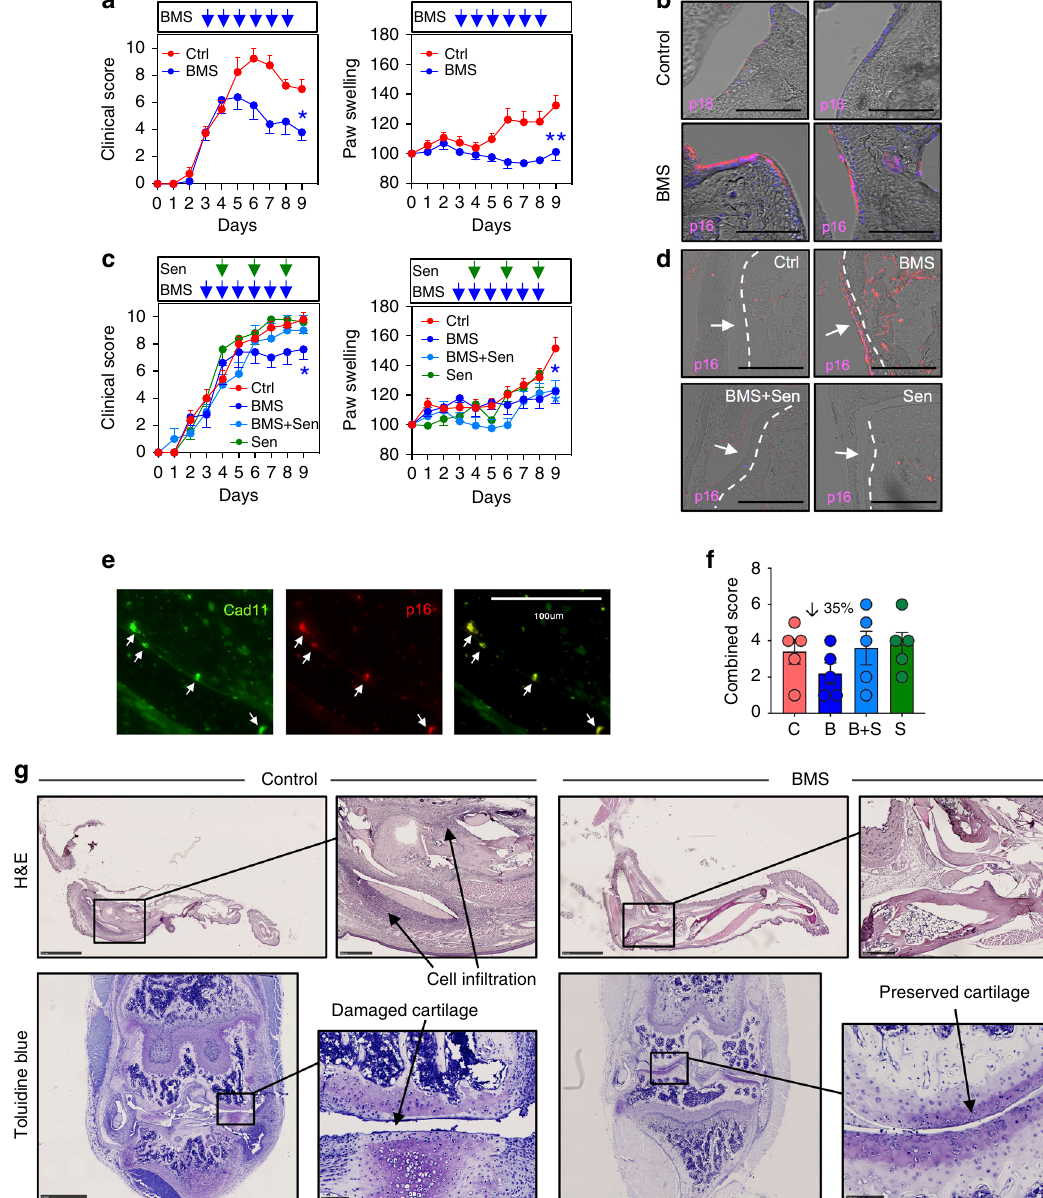
Fig. 6 Anti-arthritic actions of BMS are associated with SF senescence. a Arthritis was induced in C57BL/6NCrl mice with two injections of 100 μ l KBN serum on day 0 and day 2. BMS was administered intraperitoneally daily at the dose of 18 mg/kg from day 3. Clinical score and paw swelling were recorded daily. Data are mean ± SE ( n = 5, Student ’ s t -test vs. control day 9, Ctrl; * p < 0.05, ** p < 0.01). b p16 INK4 expression was assessed by immuno fl uorescence on EDTA-decalci fi ed and paraf fi n-embedded knee joint sections. p16 INK4 immunostaining is shown in pink while nuclear staining with DAPI is in blue. Scale bars indicate 100 μ m. c Arthritis was induced with two injections of 150 μ l KBN serum on days 0 and 2. BMS was administered intraperitoneally at a daily dose of 18 mg/kg from day 3. From day 4, senolytics (Sen, dasatinib + quercetin at doses of 2.5 and 10 mg/kg, respectively) were administered intraperitoneally on alternate days. Data are mean ± SE ( n = 5, Student ’ s t -test vs. control at day 9, Ctrl; * p < 0.05). d p16 INK4 expression was assessed by immuno fl uorescence on EDTA-decalci fi ed and paraf fi n-embedded knee joints sections. p16 INK4 is shown in pink. Arrows and dotted lines indicate synovial lining. e Co-localization by immuno fl uorescence of senescence marker p16 INK4 and the SF marker cadherin-11, Cad11, in knee joins of arthritic mice treated with BMS. Scale bars indicate 100 μ m. f Representative images of H&E (ankle joints) and Toluidine blue (knee joints) staining, indicating the degree of cell in fi ltration (H&E) and cartilage integrity (Toluidine blue) in control and BMS-treated mice. Data are mean ± SE ( n = 5). g The extent of cell in fi ltration and cartilage damage were combined in a cumulative damage score (max = 6). Data values are mean ± SE ( n = 5). Scale bars indicate 2.5 mm and 500 μ m for H&E, and 1 mm and 100 μ m for Toluidine blue. Source data are provided as Source Data fi